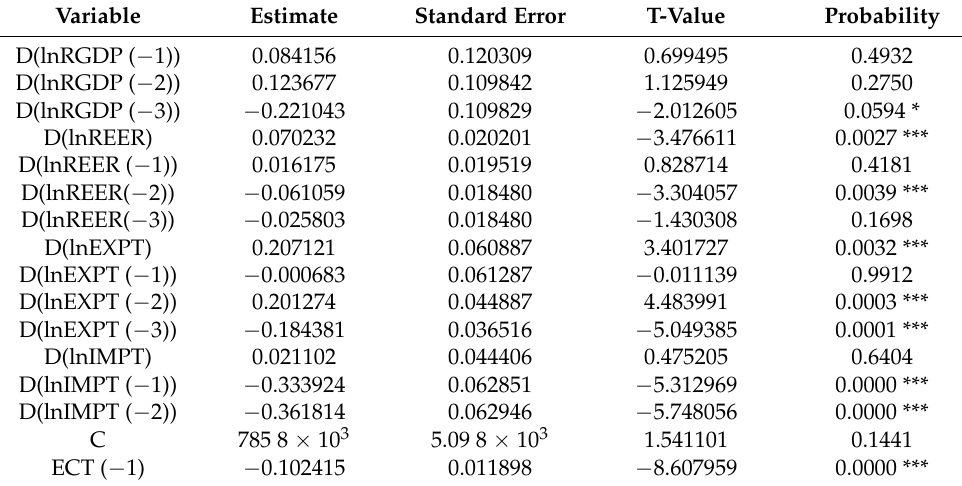
Table 5. Short-Run Relationship along with ECM.